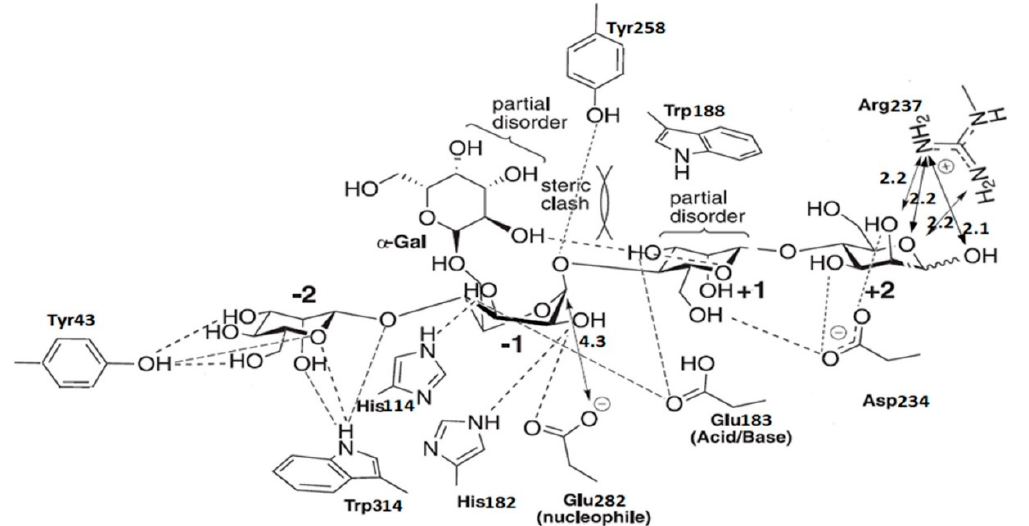
Figure 4. Diagrammatic sketch of the interactions of Man26E and manno-oligosaccharide